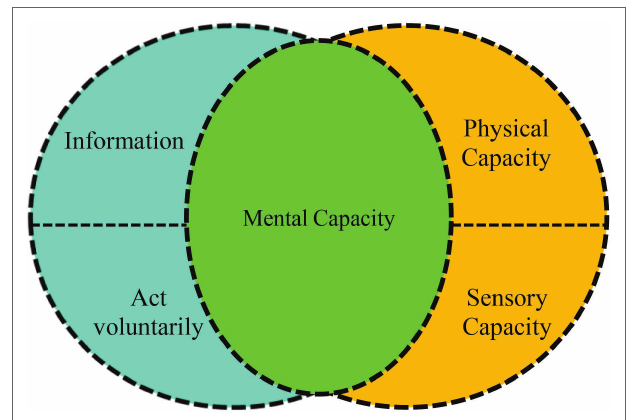
FIGURE 1 | Relationship between decisional and functional